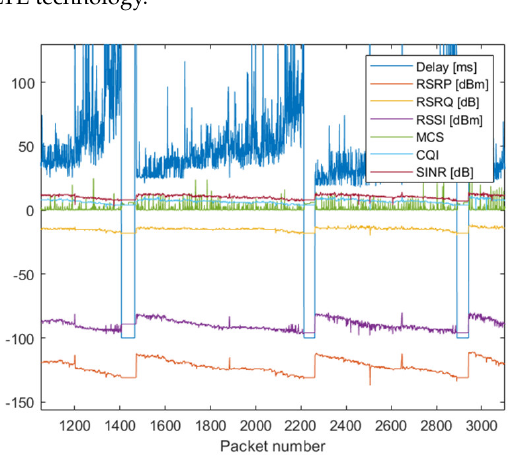
Figure 11. The enlarged plot from Figure 10. Table 1. The number of realized transmissions and lost packets for each MCS.